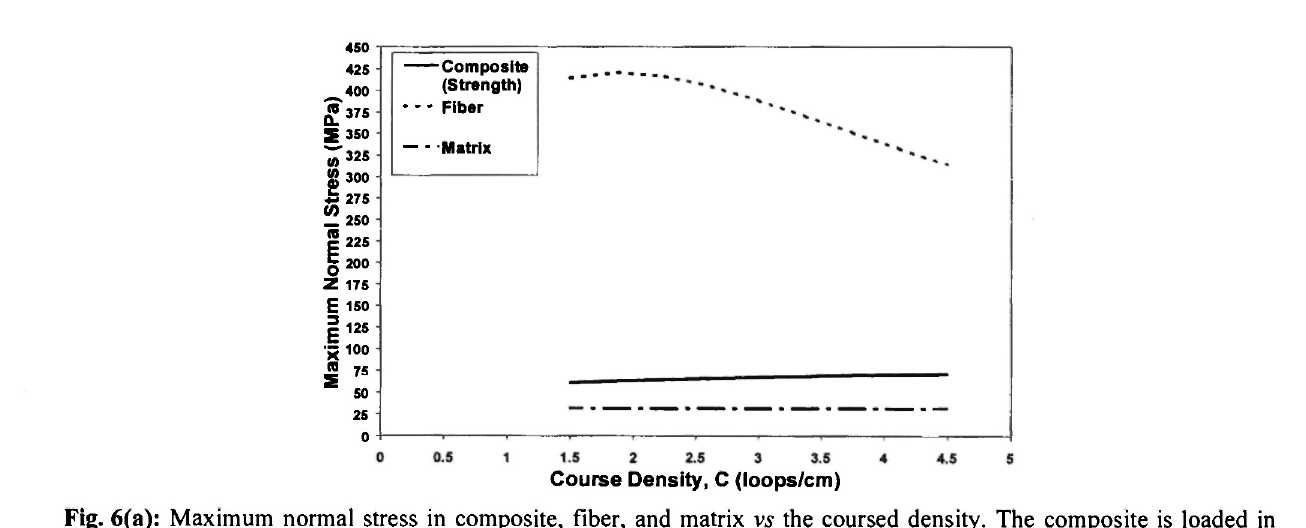
Fig. 6(a): Maximum normal stress in composite, fiber, and matrix vs the coursed density. The composite is loaded in wale direction. The geometric parameters used are: p f = 2.54g/cm 3 , cM).0445cm, 0^=177.8(Tex), Λ=0.45, ^=2loop/cm and /=0.06cm.